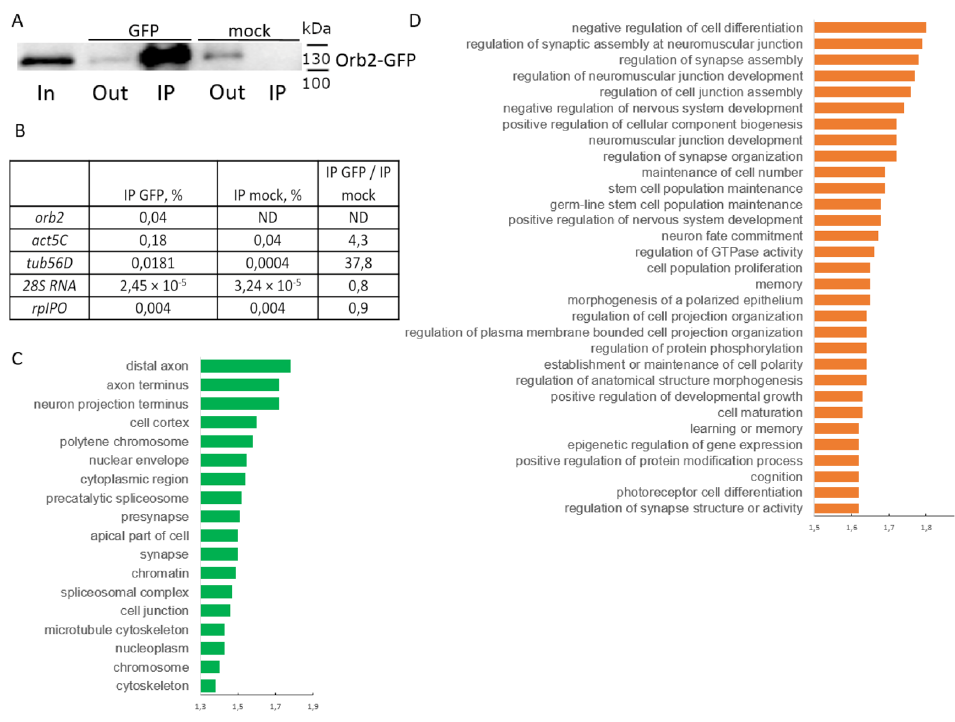
Figure 5. Immunoprecipitation of Orb2 mRNA targets. ( A ) Western blot analysis of samples obtained in the IP procedure with antibodies against GFP. ( B ) The yield (% of input) of several mRNAs obtained in the IP reaction and enrichment of these mRNAs in GFP IP vs. mock IP. ( C , D ) Overrepresented GO terms of cell components ( C ) and biological processes ( D ) in genes of the list obtained. Bars represent fold enrichment.